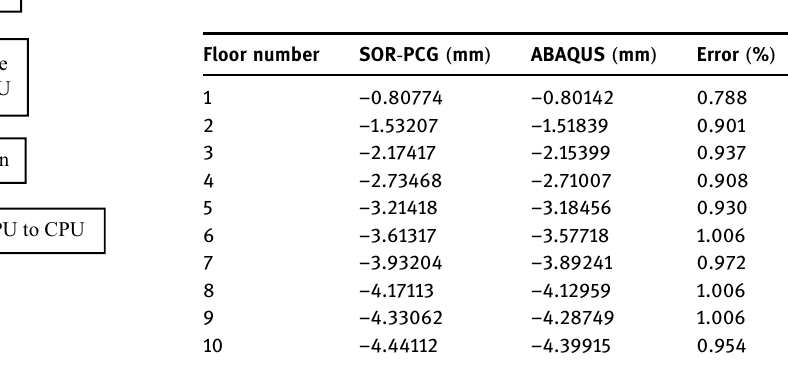
Table 1: Vertical displacement of the middle column at